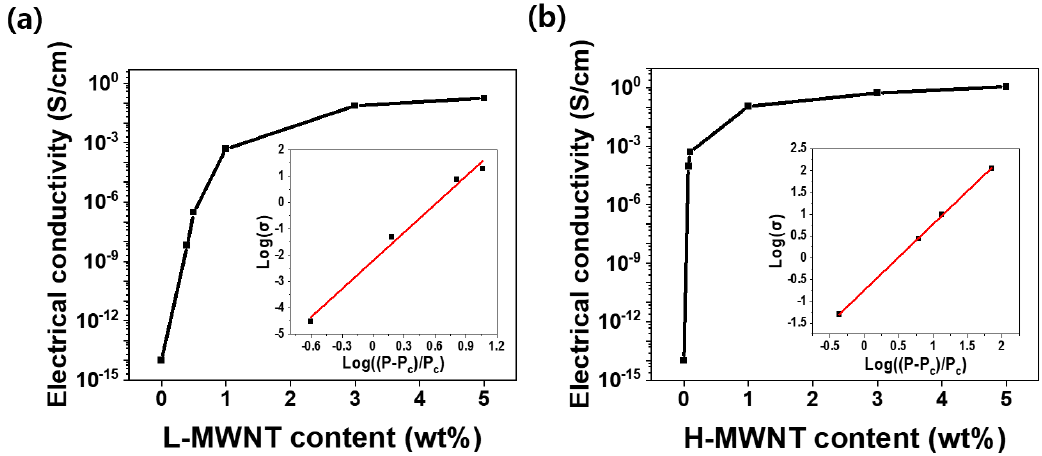
Figure 3. Electrical conductivity versus MWNT content: ( a ) L-MWNT/PDMS composite and ( b ) H-MWNT/PDMS composite. The insets in the figures refer to the log( σ ) value versus log((P − P c )/P c ).